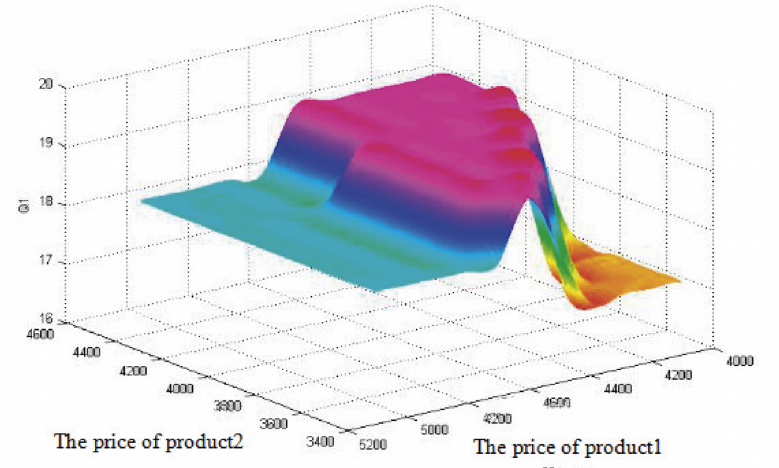
Figure 3. The curve of the total order quantity Q1 that the retailer reserves to Manufacturer 1 before the selling season as Lenovo and Hewlett Packard computer prices